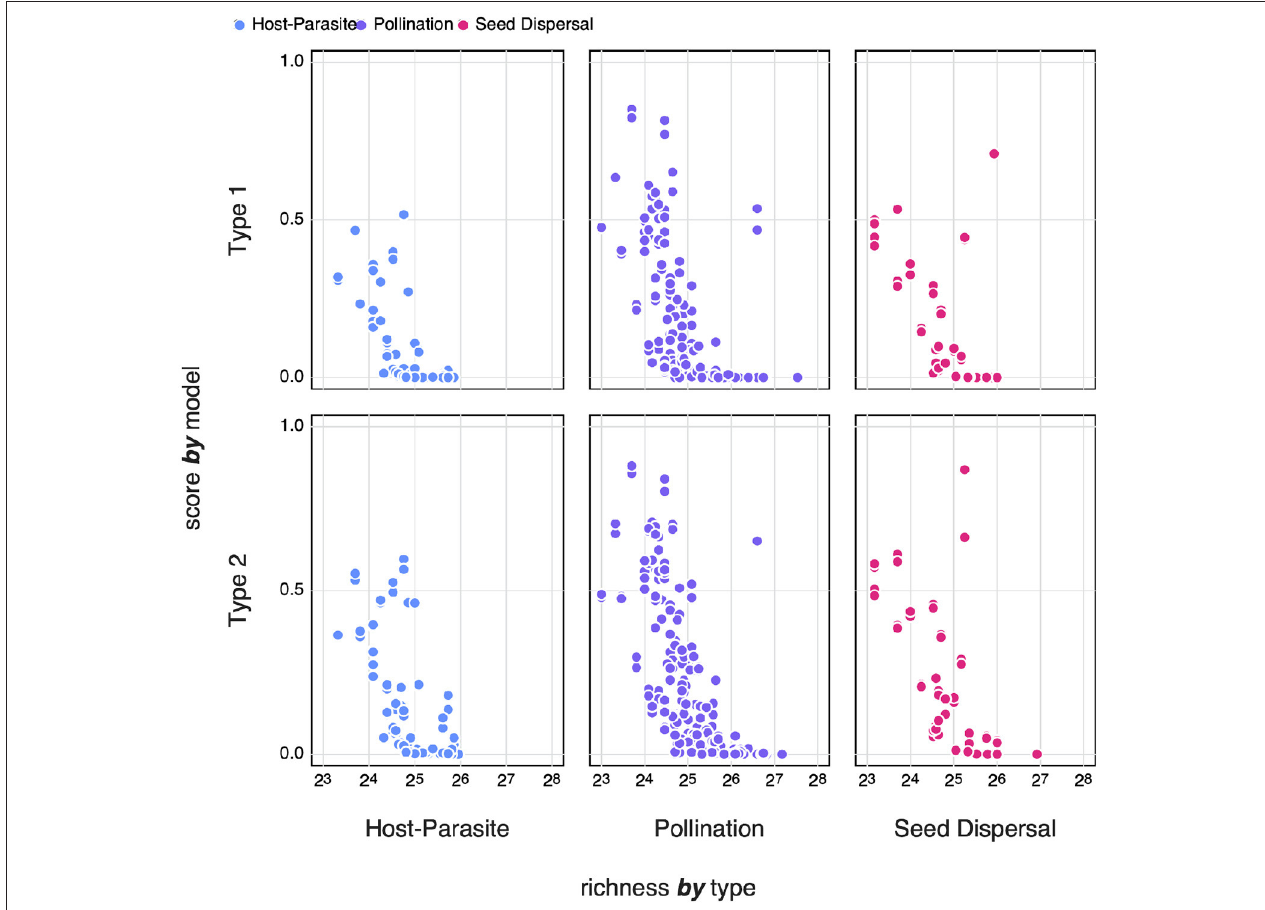
FIGURE 8 | The logistic z i -scores of different types of networks for both Type I and Type II null models compared to the species richness of the network. Where z i -scores below 0.5 indicate networks with an SVD entropy that is lower i.e., less complex than